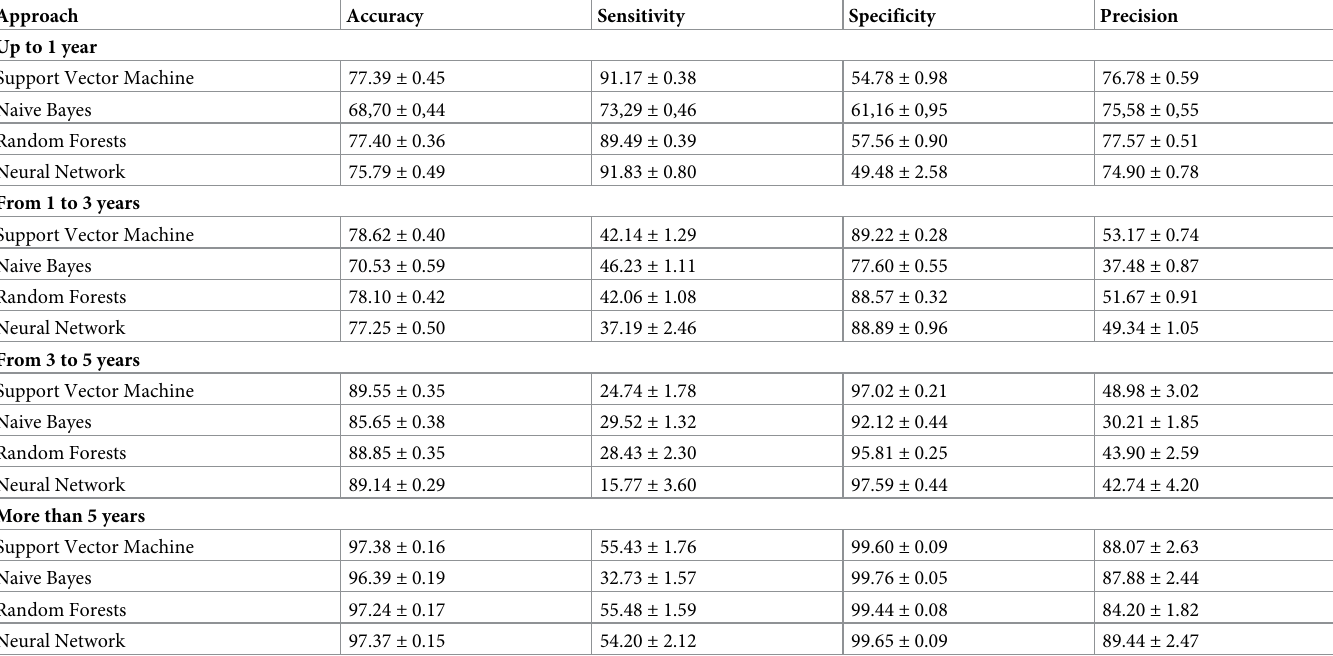
Table 5. Measures of performance of the models in the test phase and the 10-fold cross-validation (mean ± standard